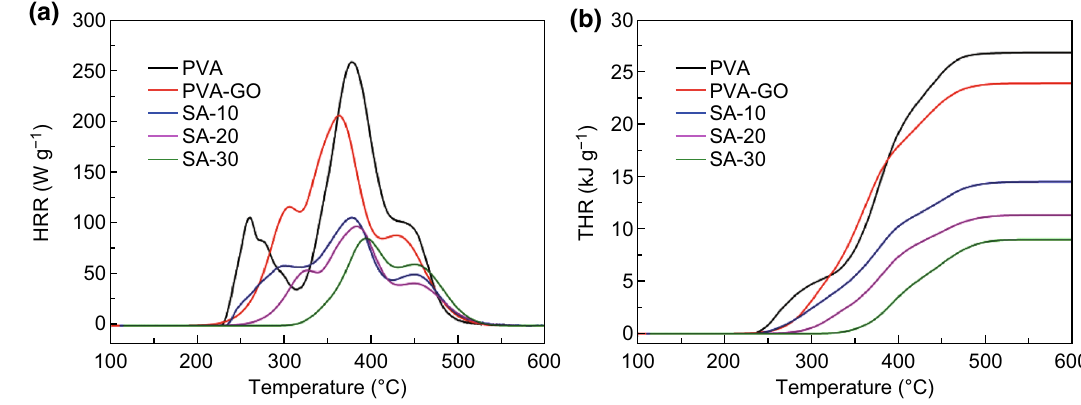
Fig. 7 a HRR and b THR profiles of pure PVA, PVA/GO, and self-assembled FGO-coated PVA with different numbers of